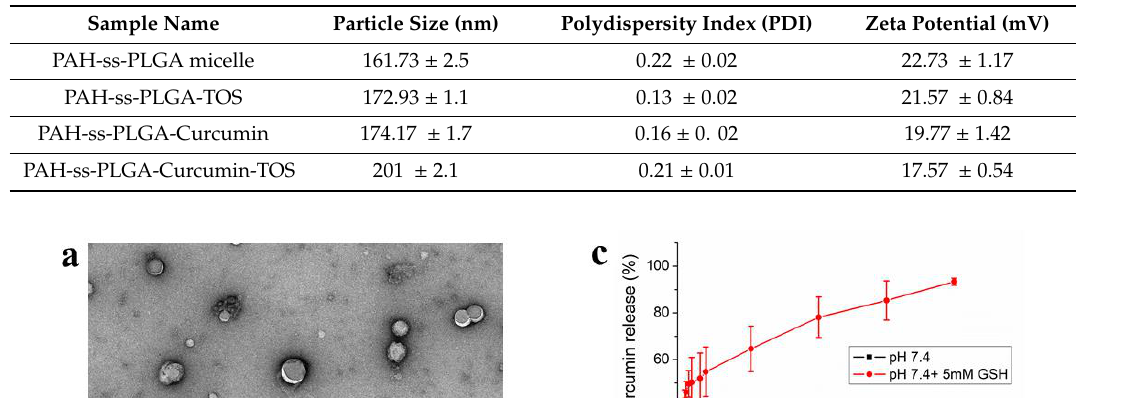
Table 1. The mean particle size, polydispersity index (PI), and zeta potential of empty, TOS, and / or